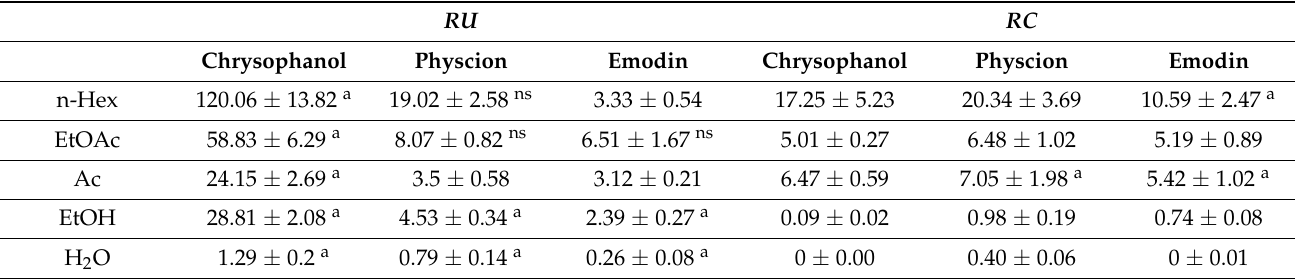
Table 2. Quantitative HPLC analysis of the RU and RC extracts.